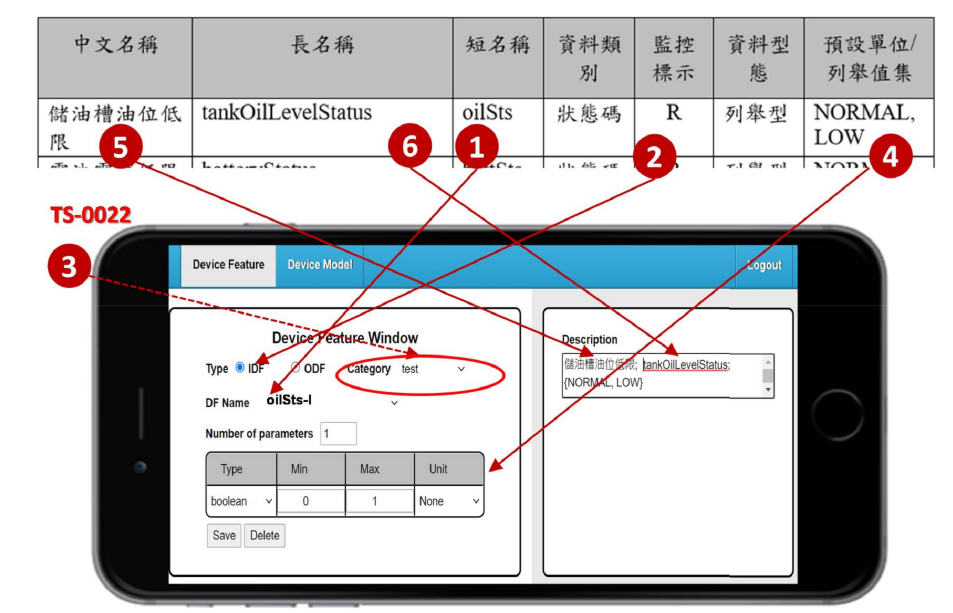
Figure 3. Device Feature (DF)